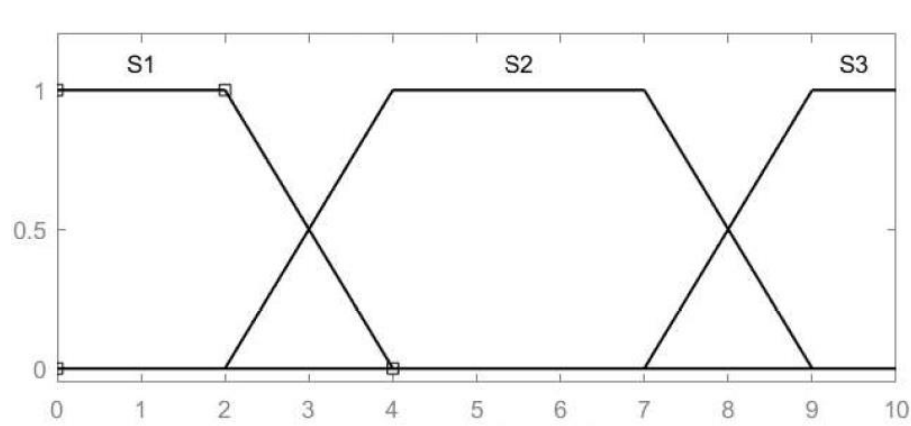
Figure 7. Membership function of severity .